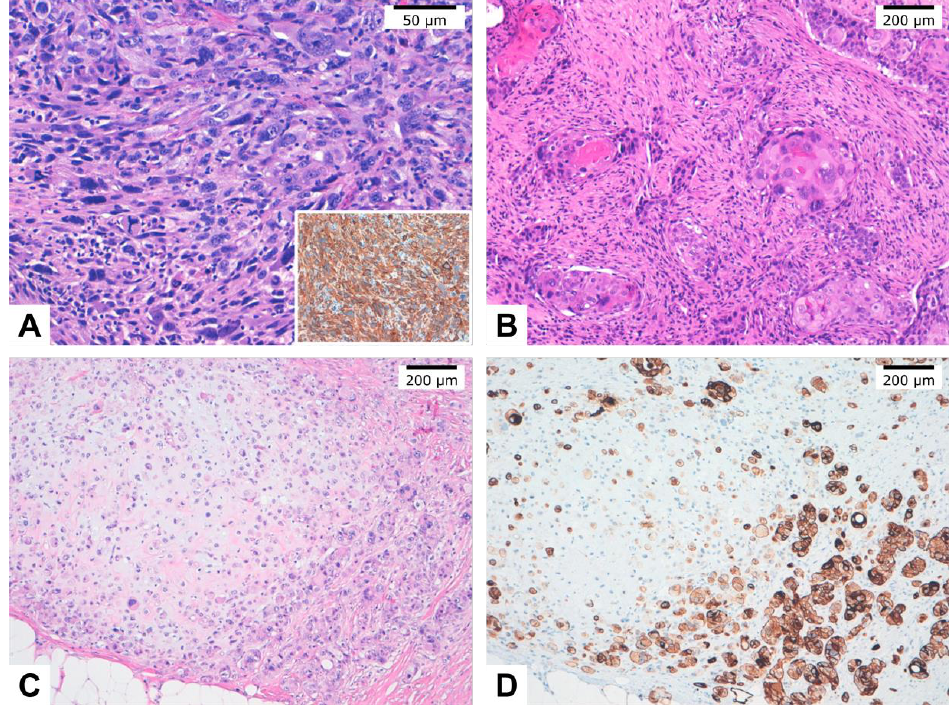
Figure 1. Histopathological images of different metaplastic breast carcinoma subtypes. ( A ). Spindle cell carcinoma entirely composed of neoplastic spindle cells. Inset: Immunohistochemistry showed cytokeratin AE1/AE3 diffuse and intense staining in tumor cells. ( B ). Squamous cell carcinoma with keratin pearls. ( C ). Metaplastic carcinoma with mesenchymal (chondroid) differentiation (matrix-producing carcinoma). ( D ). Immunohistochemistry of case C showed cytokeratin AE1/AE3 expression staining in tumor cells.